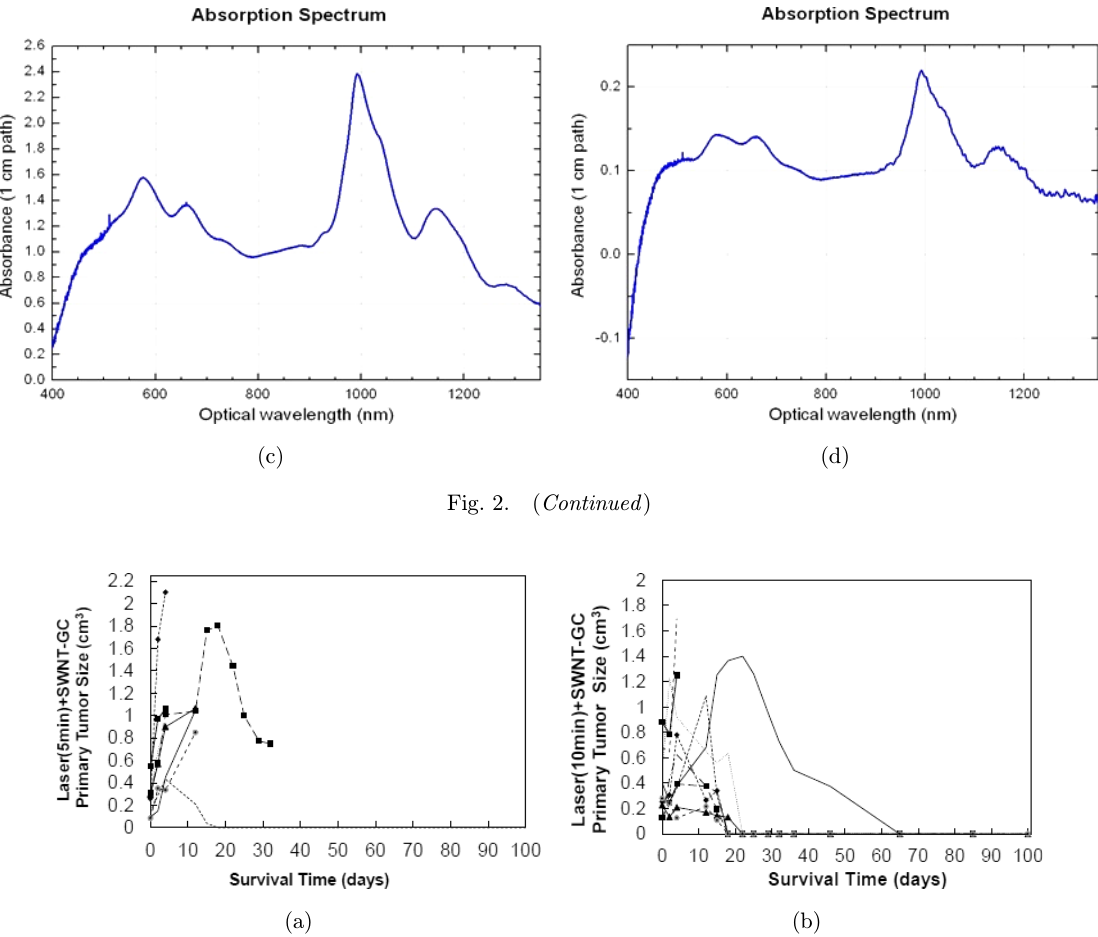
Fig. 3. Regression of primary tumors. Tumor-bearing rats were treated 10 – 14 days after tumor inoculation, when tumor volume was approximately 0.5 cm 3 . A 200- (cid:1) l solution of SWNT – GC (100 – 1000 (cid:1) g) was injected directly into the center of the primary tumor 2 h prior to laser irradiation, with a power density of 1.0 W/cm 2 for either 5 or 10 min. (a) Volumetric measurements of primary tumors receiving SWNT – GC and 5 min of laser irradiation. (b) Volumetric measurements of primary tumors receiving SWNT – GC and 10 min of laser irradiation.